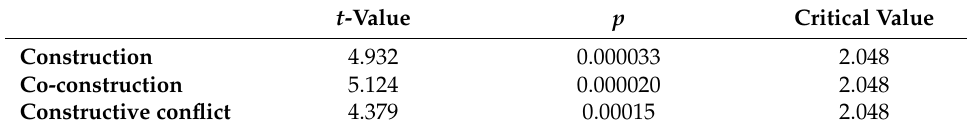
Table 14. Obtained t -test